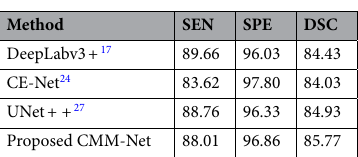
Table 6. Overall evaluation (%) for all medical image modalities.